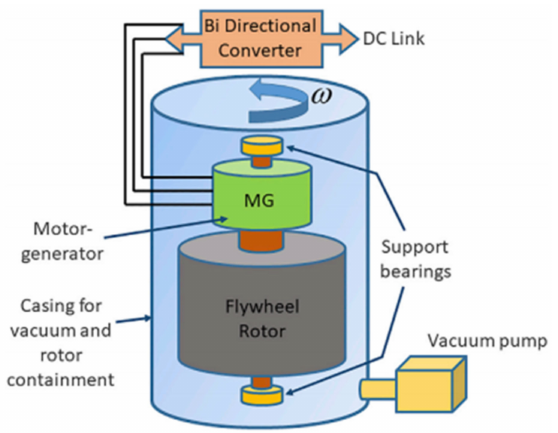
Figure 4. Components of a flywheel system for electrical storage based on [8] reproduced by